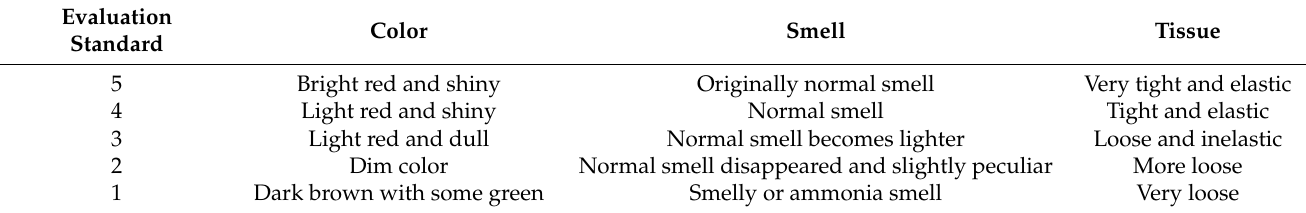
Table 2. The specific evaluation standard of chilled